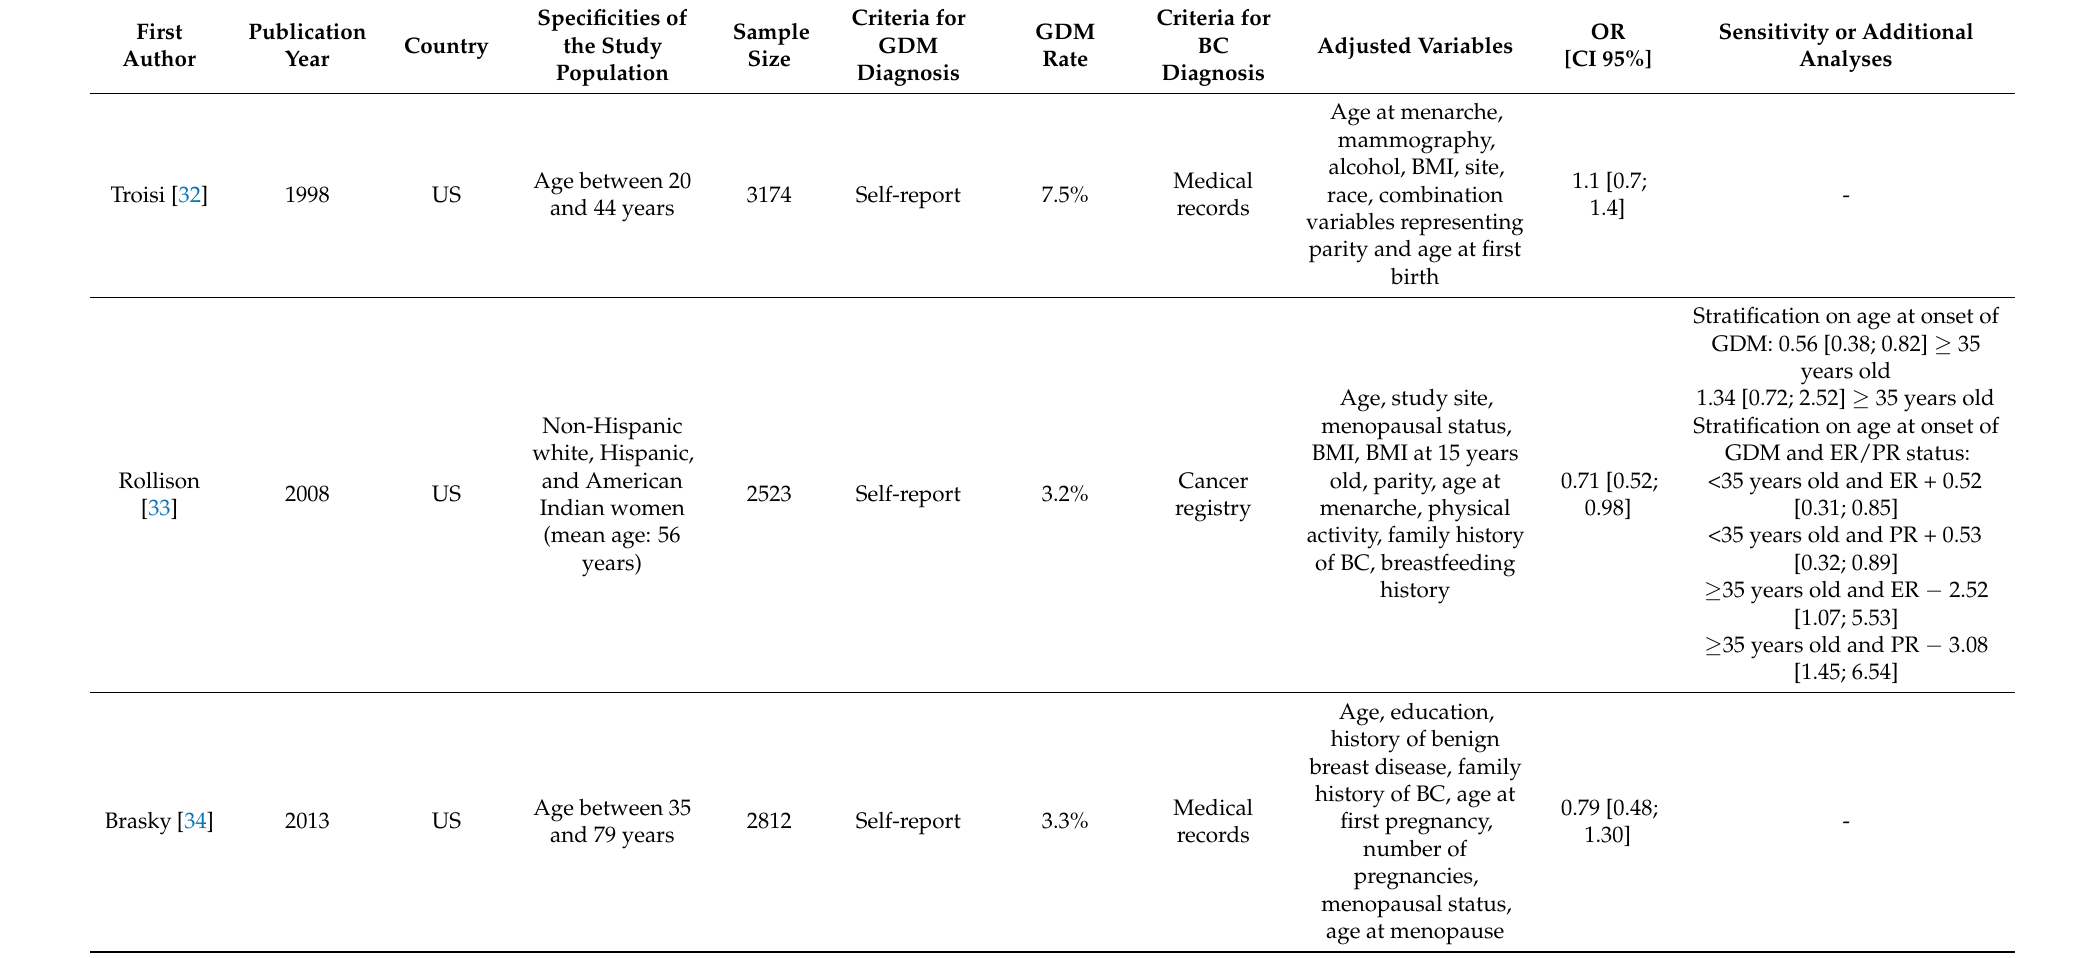
Table 2. Characteristics of the case-control